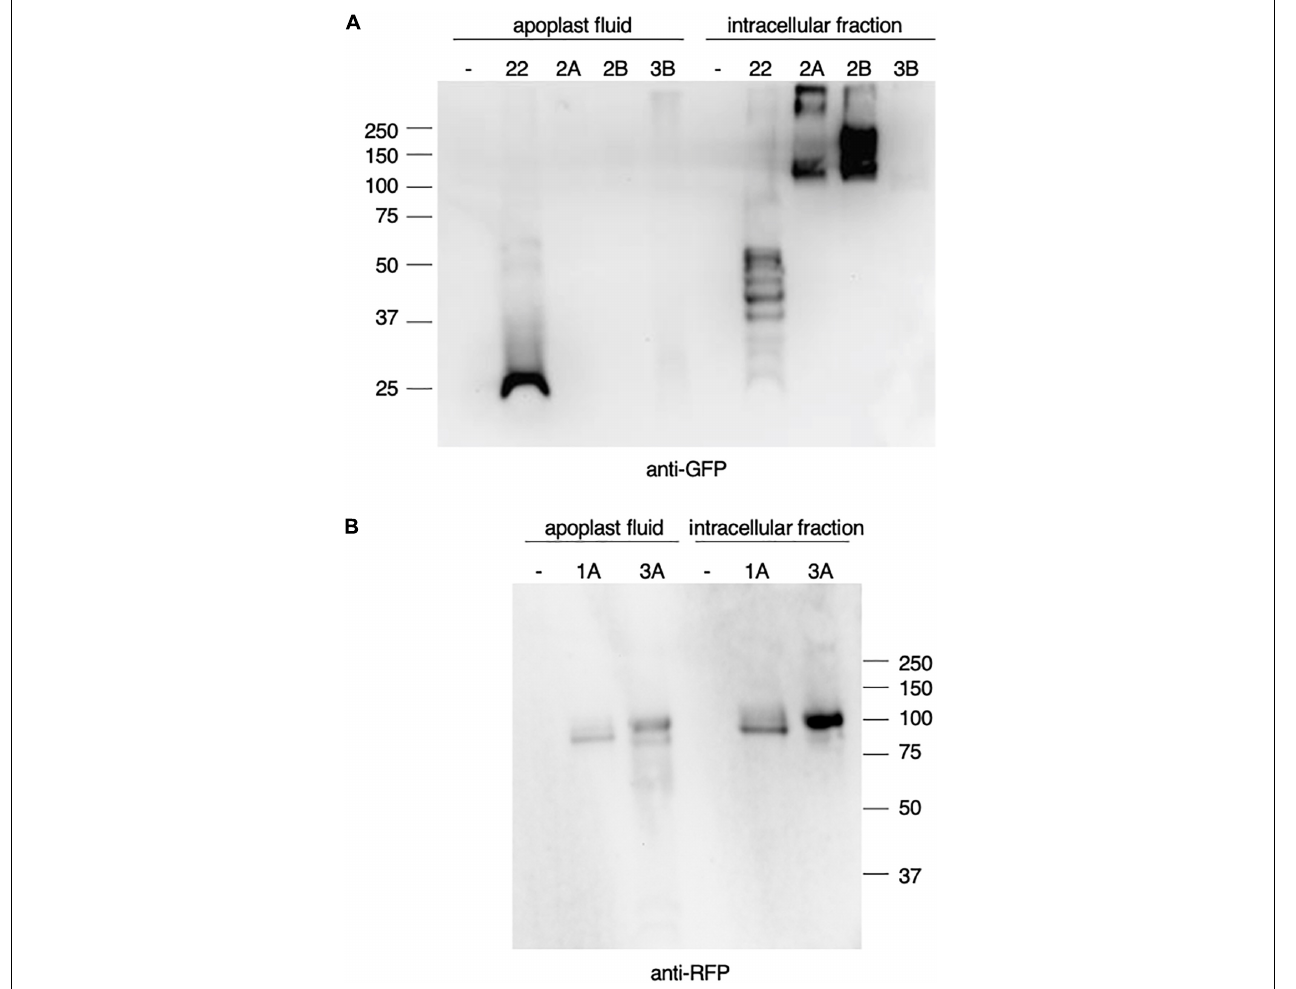
FIGURE 2 | Expression of Nicotiana benthamiana beta-hexosaminidases (HEXOs). GFP- or RFP-tagged HEXOs or IL-22-GFP (used as apoplast control protein) were transiently expressed in N. benthamiana leaves. As a negative control (–) p19 was used. Leaves were harvested 3 days post infiltration and analyzed by western blot. (A) anti-GFP western blot under reducing conditions of 10 µ g total soluble protein of apoplast fluids or intracellular fraction upon expression of IL-22-GFP (22), HEXO2A (2A), HEXO2B (2B), or HEXO3B (3B). (B) anti-RFP western blot under reducing conditions of 10 µ g total soluble protein of apoplast fluids or intracellular fraction upon expression of HEXO1A (1A) or HEXO3A